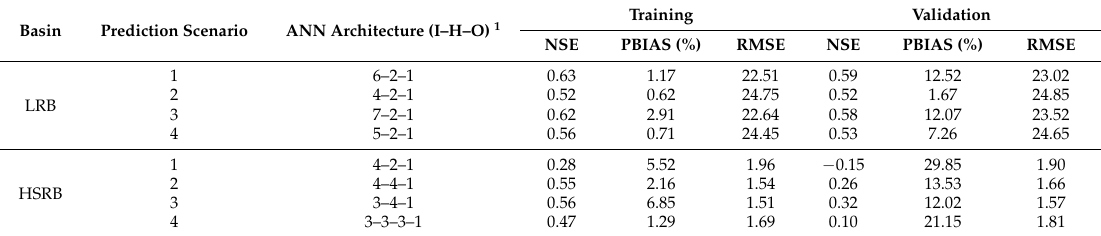
Table 8. Best network architectures and their average performance measures obtained in cross-validation for each prediction scenario.